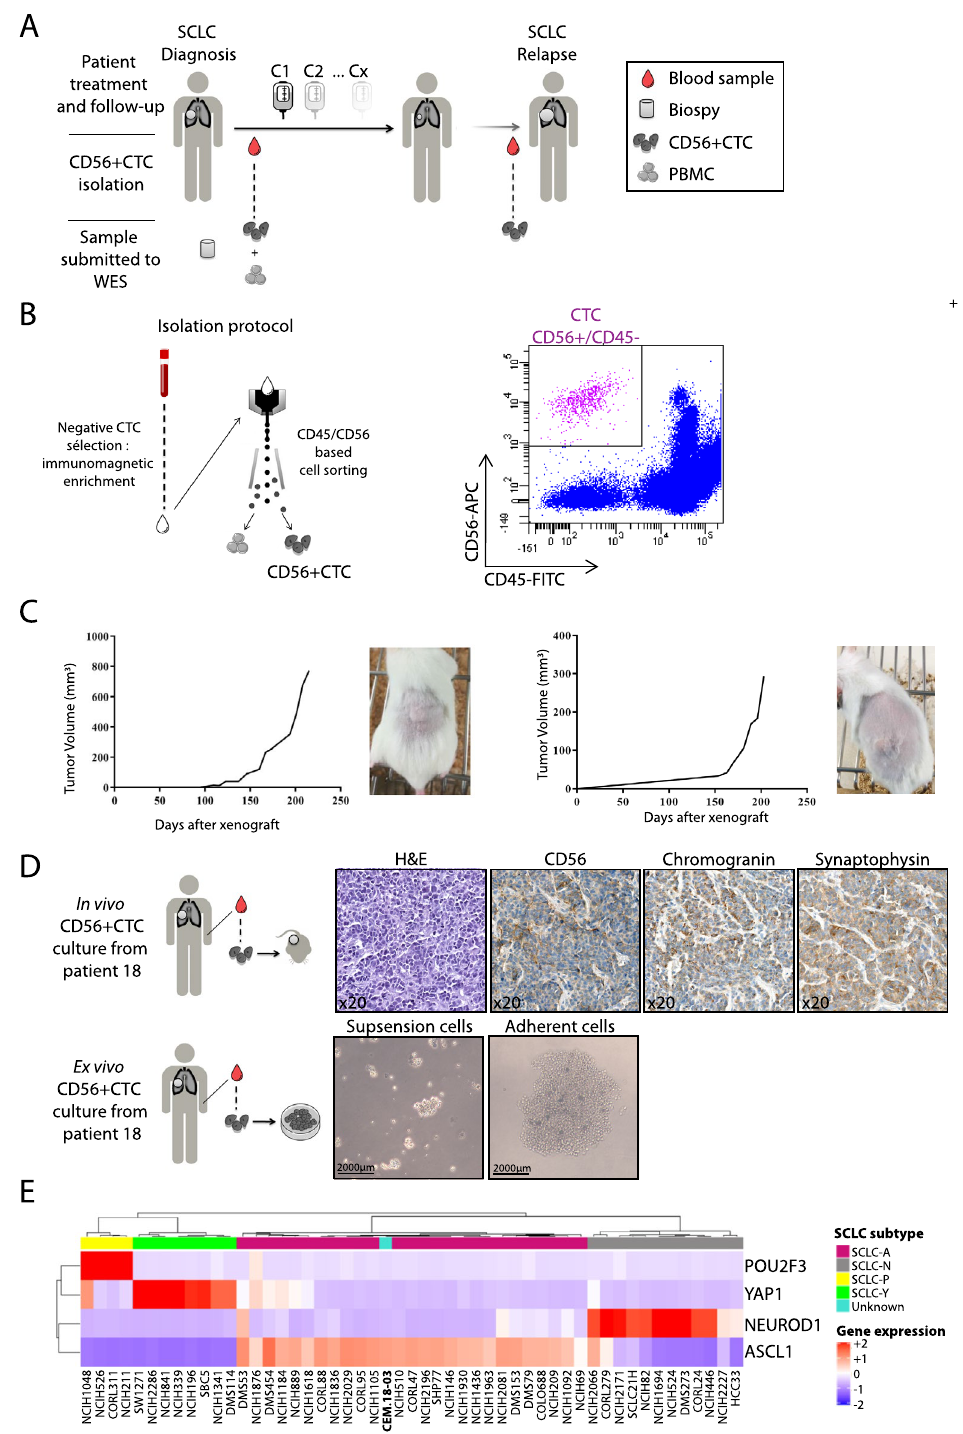
Figure 1. Isolation of CD56+ CTCs and generation of pre-clinical models. ( A ) Schematic workflow of the CTC-CPC study. ( B ) Isolation procedure of CD56+ CTC from whole blood sample (left panel); Representative result of flow cytometry cell sorting (right panel). ( C ) Circulating tumor cells-derived xenograft (CDX) obtained from isolated CD56+ CTC. ( D ) IHC phenotype of in vivo models obtained from isolated CD56+ CTC (upper panel); ex vivo cell lines obtained from isolated CD56+ CTC (lower panel). ( E ) Heatmap and hierarchical clustering based on the expression data of the four (established) key transcription regulators that are (commonly) used to identify the SCLC molecular subtype. Samples are derived from 50 SCLC cell lines, from CCLE with known molecular subtypes and from one patient of unknown SCLC subtype (CEM 18–03). For every gene, the color scale indicates its relative expression, from blue (low) to red